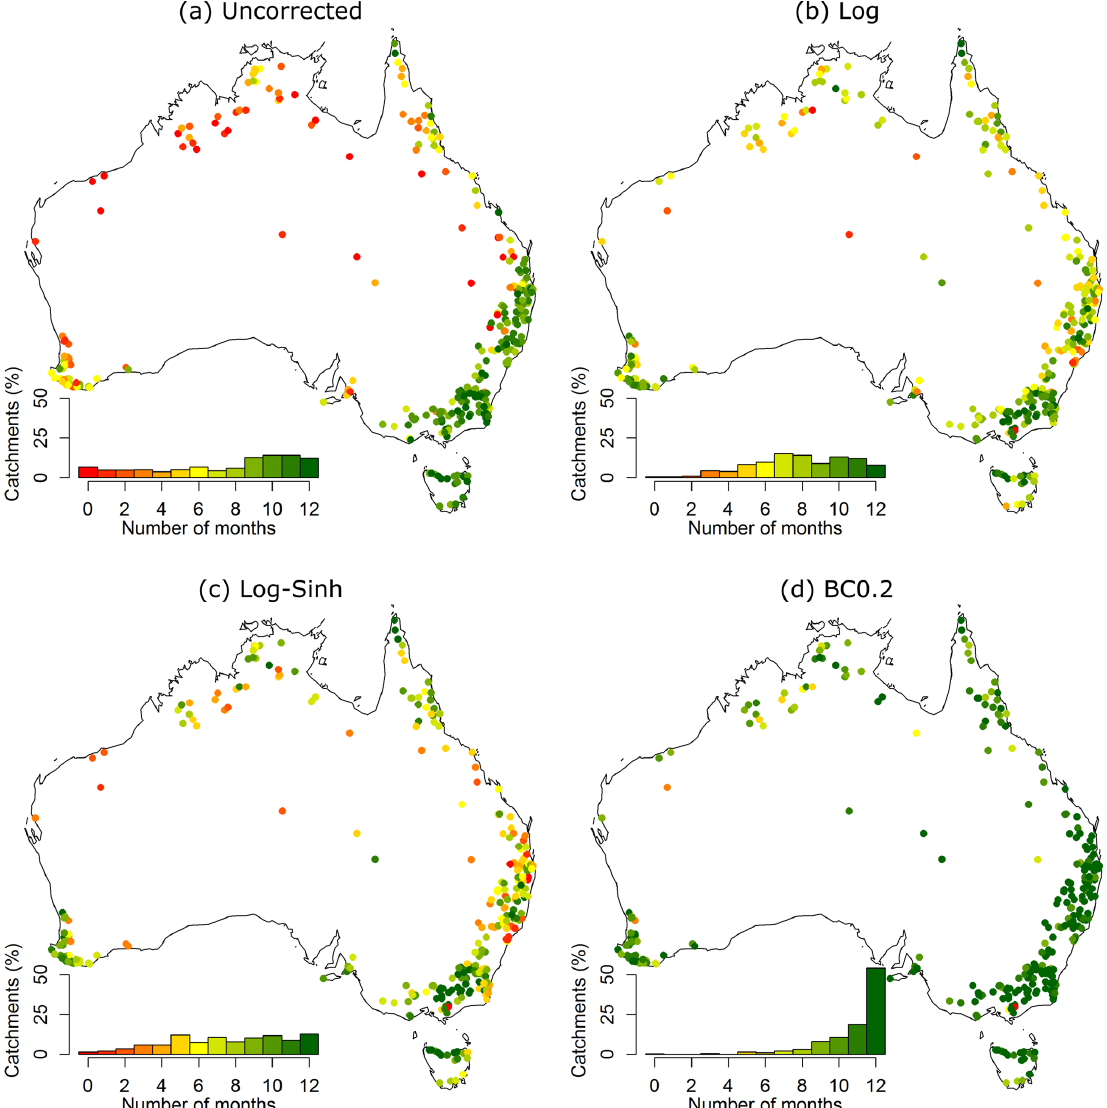
Figure 10. Summary skill of monthly forecasts obtained using the Log, Log-Sinh, and BC0.2 schemes across 300 Australian catchments. The performance of uncorrected forecasts is also shown. The summary skill is defined as the number of months where high-skill forecasts (i.e. forecasts that are reliable and sharper than climatology) are obtained. The inset histogram shows the percentage of catchments in each performance category and also serves as the colour